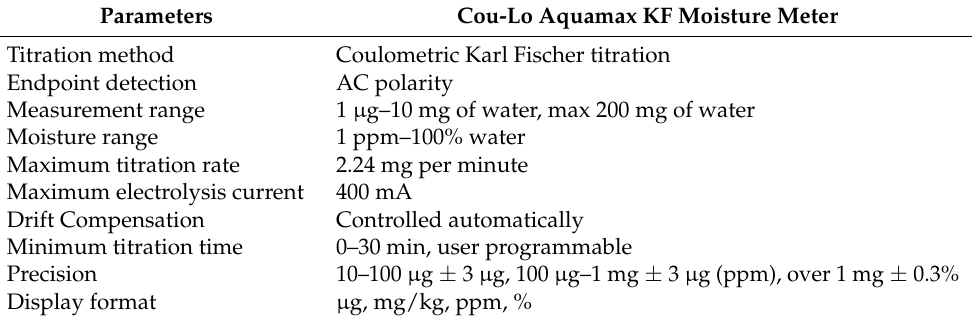
Table 1. Selected parameters of the Cou-Lo AquaMax KF automatic